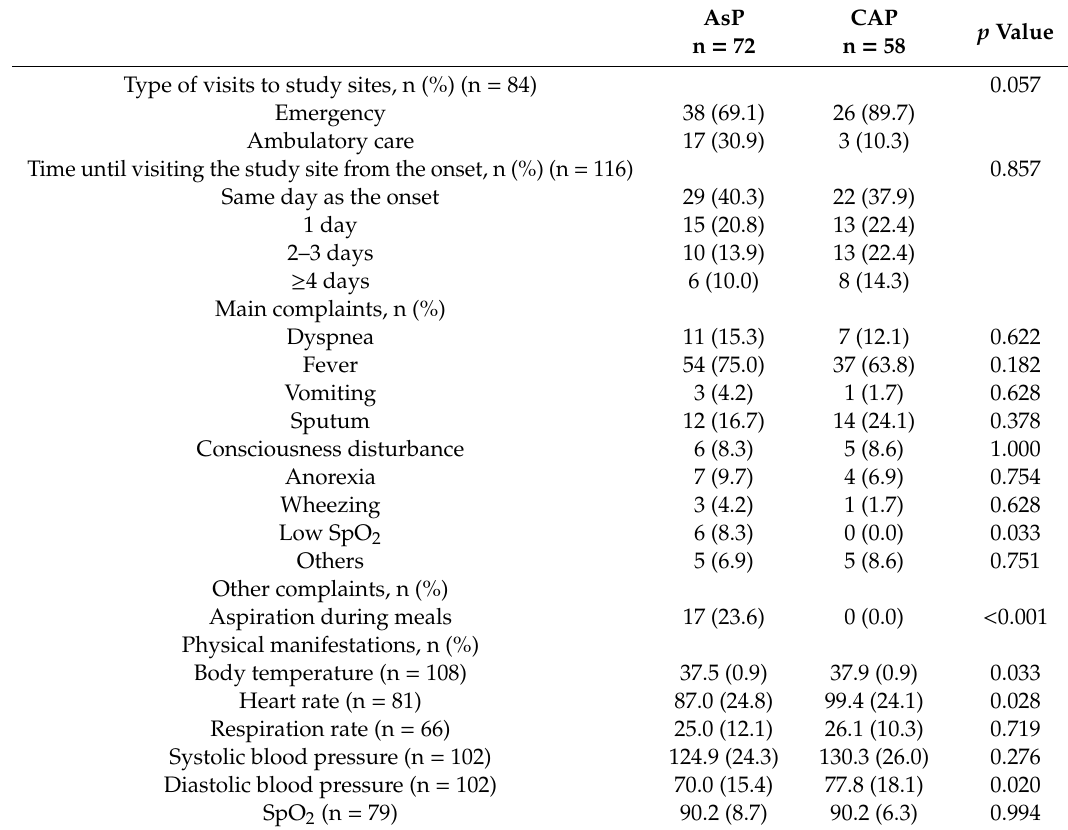
AsP CAP p Value n = 72 n = 58